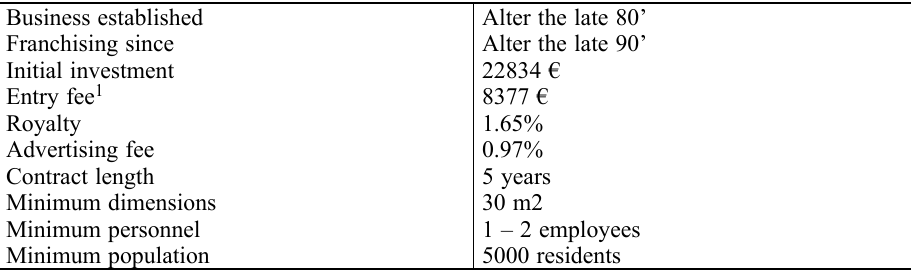
Table 2. Typical commercial establishment of travel agency franchises in Spain.